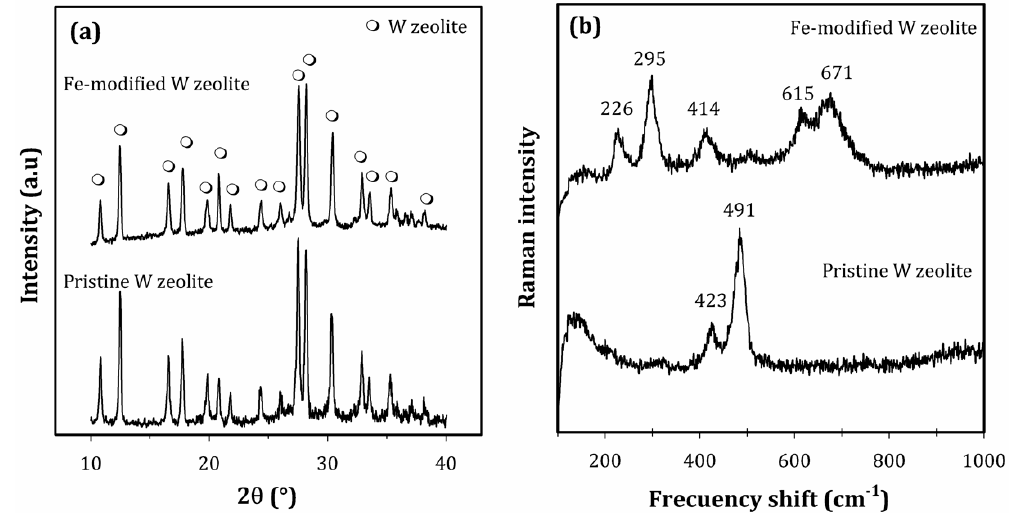
Figure 1. ( a ) XRD patterns and ( b ) Raman spectra of the pristine and Fe-modified W zeolite.